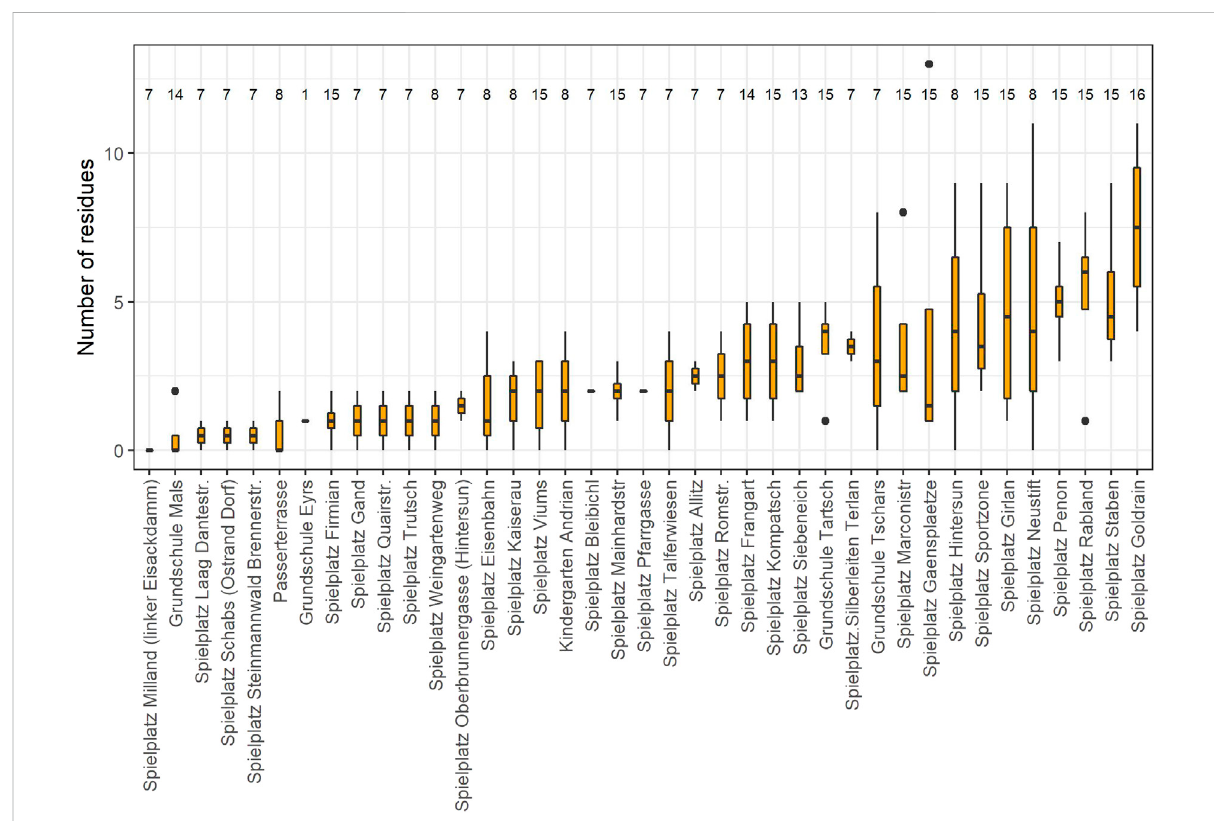
FIGURE 4 Numberofdetectedresiduespersite(playground)andyearintheperiodfrom2018to2021. “ Year ” wasusedasareplicate. Thenumbersabove the boxes represent the total number of sampling dates. For statistics see Table